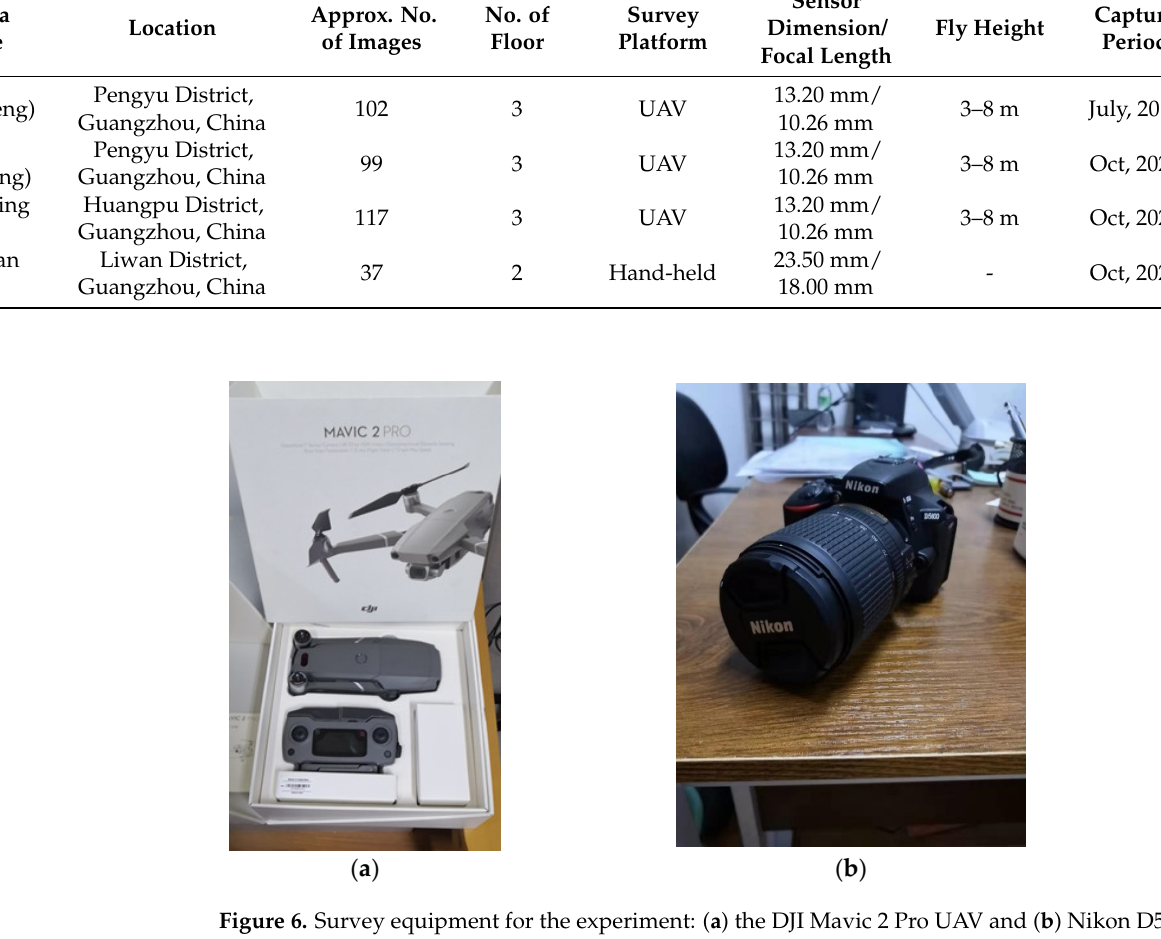
Figure 6. Survey equipment for the experiment: ( a ) the DJI Mavic 2 Pro UAV and ( b ) Nikon D5600 digital